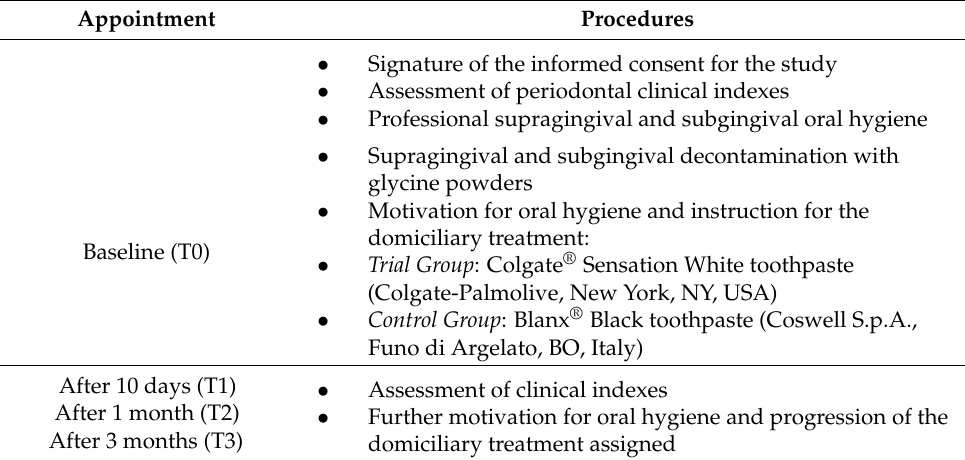
Table 3. Protocol considered for the